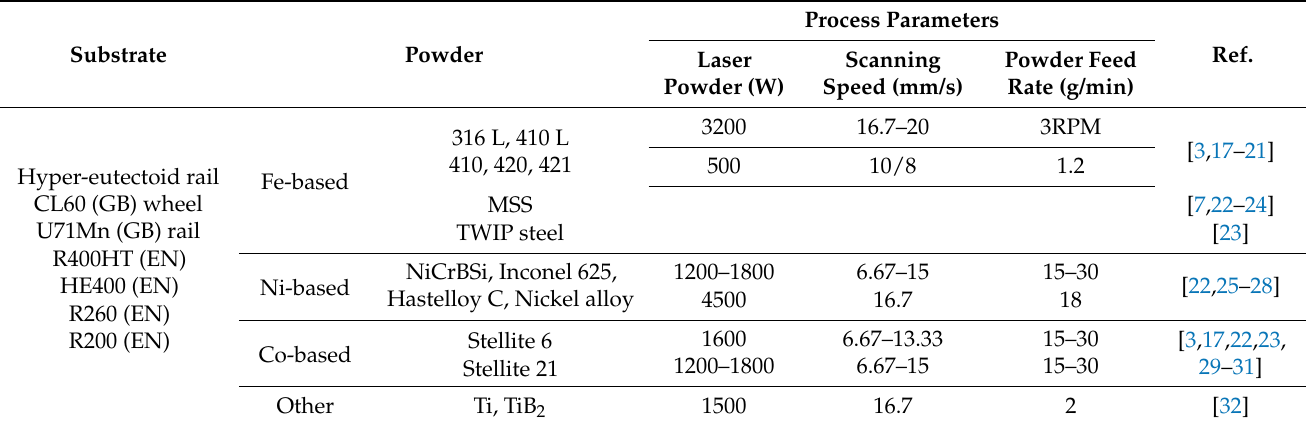
Table 1. Summary of materials used in cladded of rails by laser